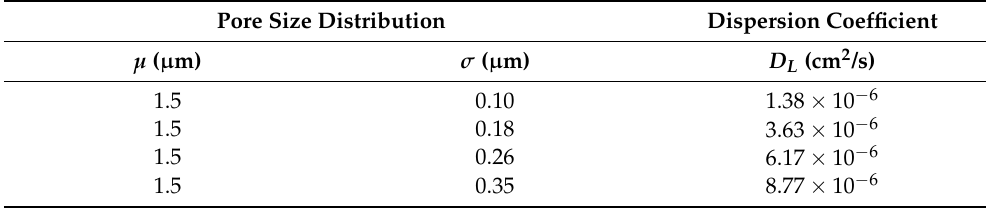
Table 5. Dispersion coefficient for each pore size distribution.